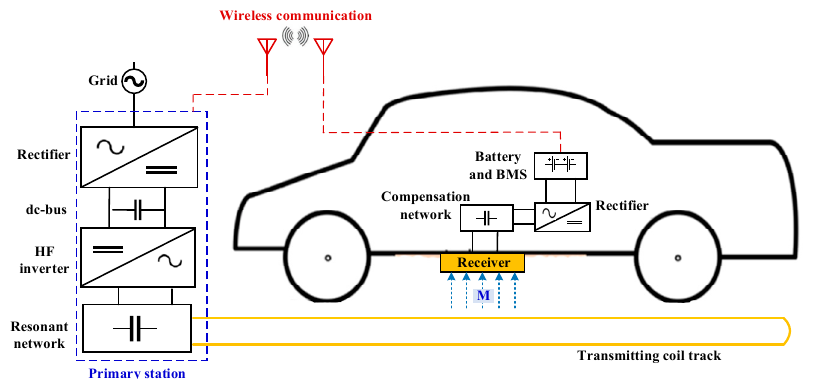
Figure 3. Components of DIPT system with single long coil track.